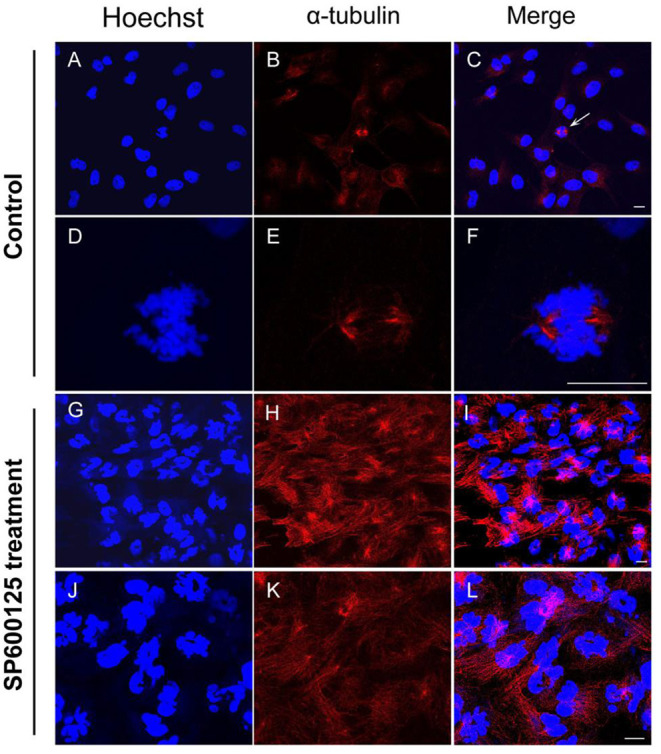
Cytological observation of SP600125-treated cells. (A–F) The control group (cultured without SP600125) and (G–L) the SP600125-treated group (SP600125 treatment for 48 h). Red regions showed the existence of tubulin using immunofluorescence staining. DNA (blue) was stained with Hoechst 33342. The white arrow in (C) showed the metaphase cells in the control group, and its enlarged parts were shown in (D–F). Scale bars represent 10 μm.